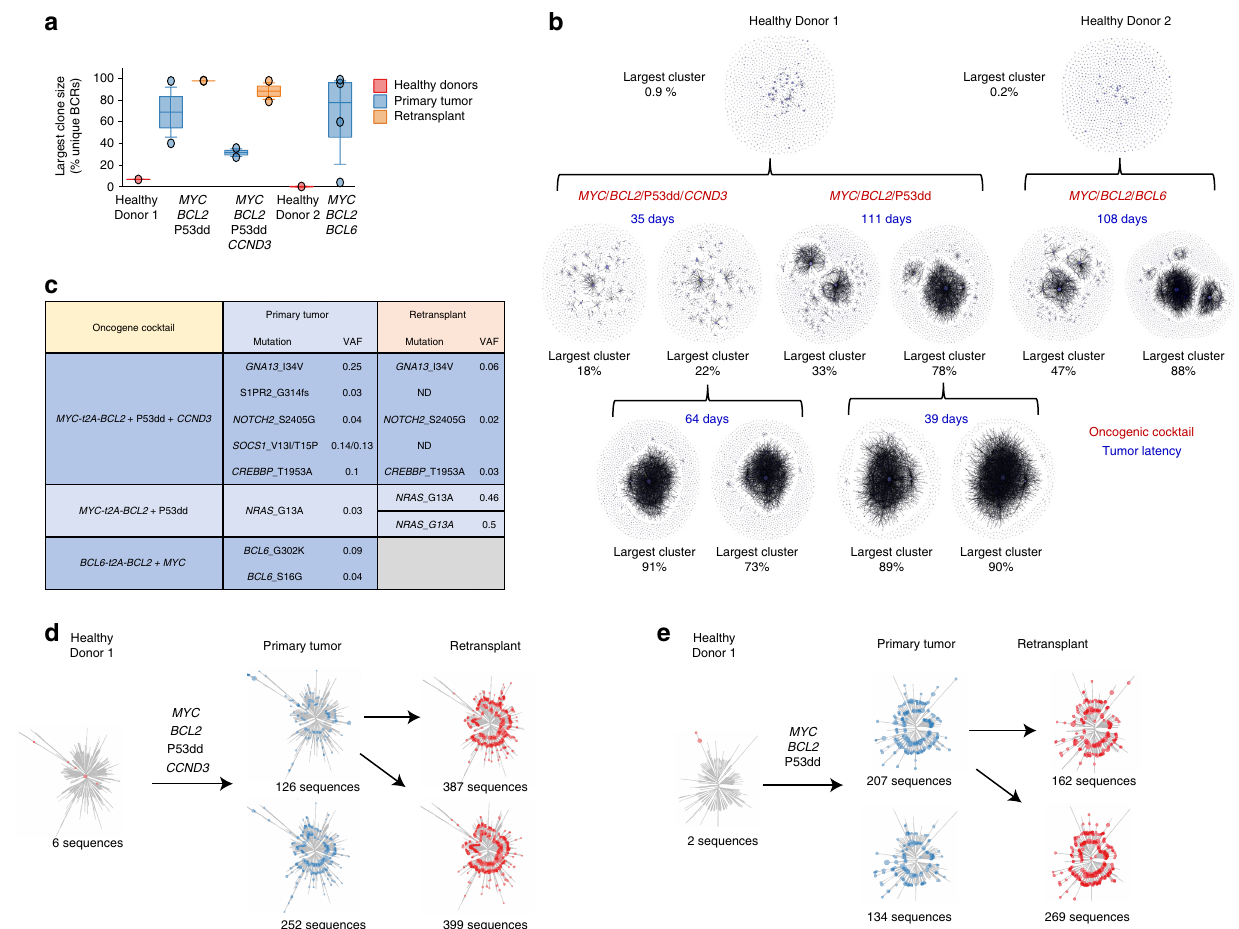
Fig. 7 Human GC B cells form tumors in immunode fi cient mice with ongoing somatic hypermutation. a Boxplot shows unique BCR counts (FR1) of primary tumors, retransplant, and healthy donor cells. Source data are provided as a Source Data fi le. b Representative BCR network plots of deep sequenced PCR ampli fi ed immunoglobulin variable gene regions from primary tumor samples ( n = 8) and retransplants ( n = 4). Each vertex represents a unique sequence, where relative vertex size is proportional to the number of identical reads. Edges join vertices that differ by single-nucleotide non-indel differences and clusters are collections of related, connected vertices. c Table shows selected mutations and their relationship in primary and retransplant tumors. d , e Unrooted phylogenetic trees of representative clonal expansions observed across samples. Each vertex is a unique BCR and branch lengths